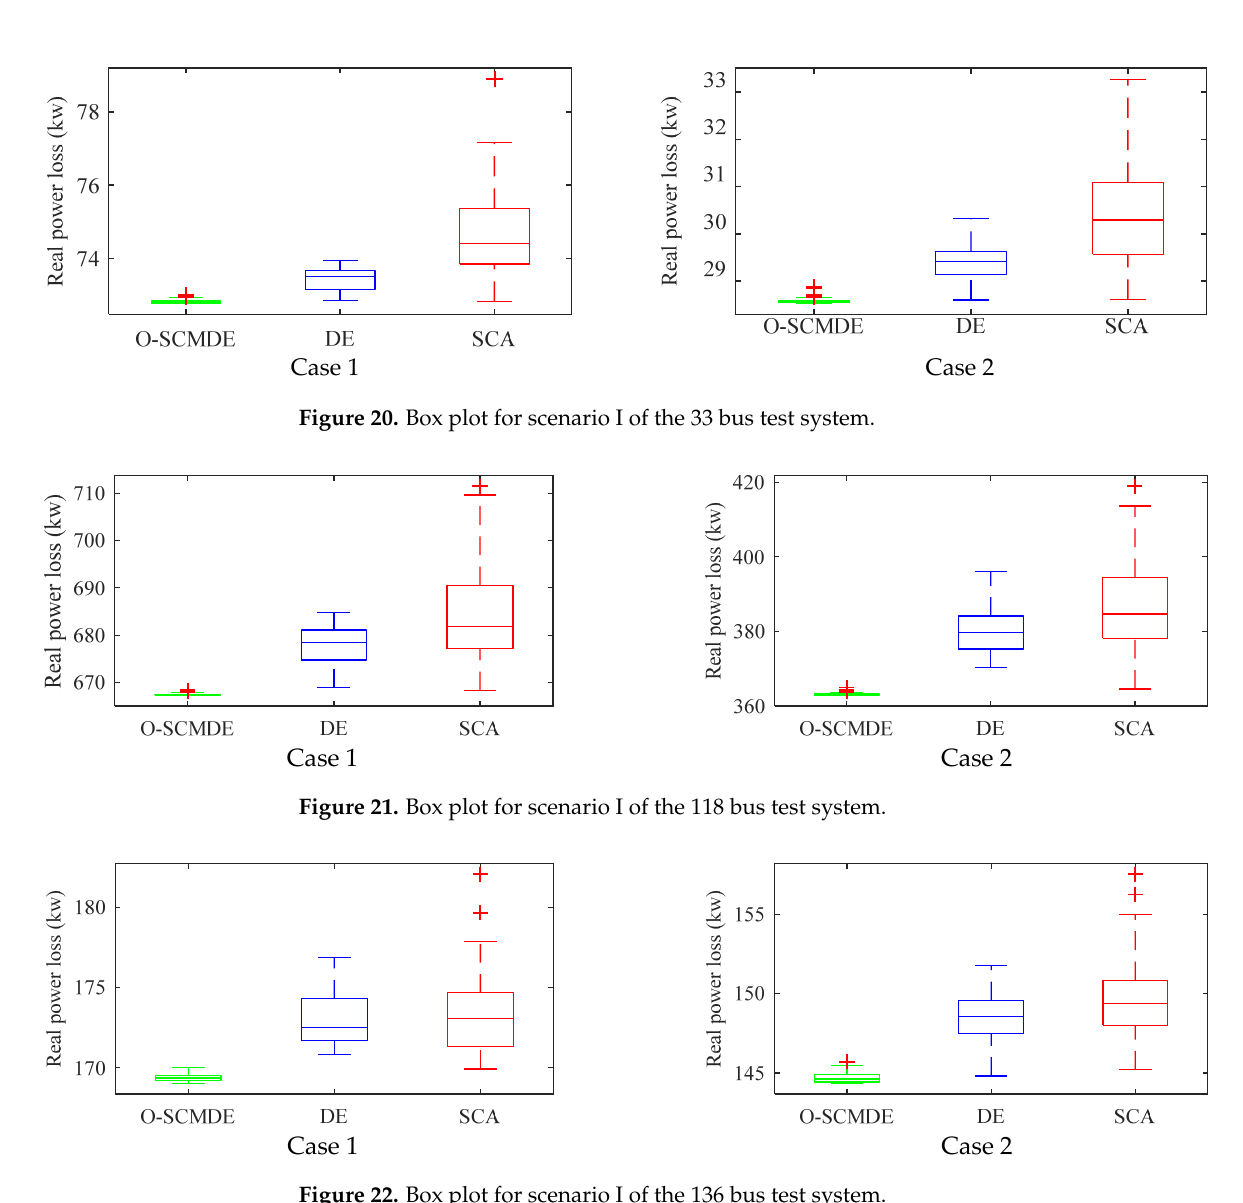
Figure 22. Box plot for scenario I of the 136 bus test system.